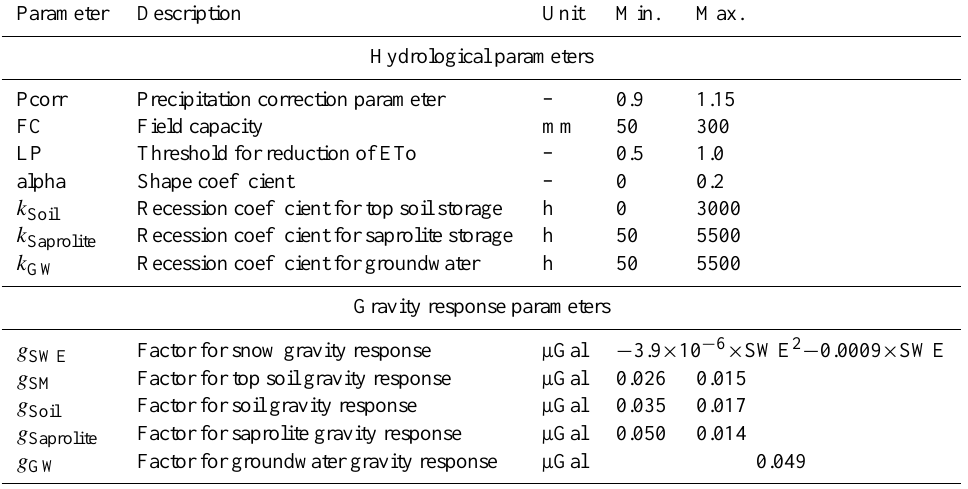
Table 2. Parameters of the hydrological model and for the estimation of the gravity response and their lower and upper bounds.